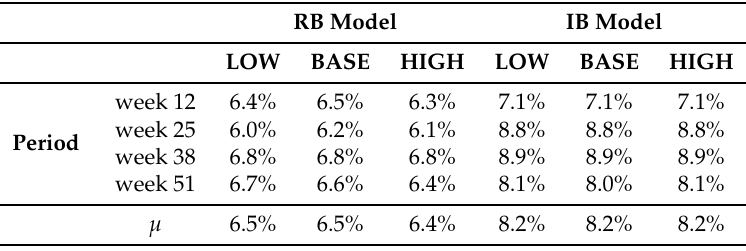
Table 5. Amount of reduction of the utility function (i.e., energy costs). Results averaged over the different consumption categories are shown for each week together with an overall average µ